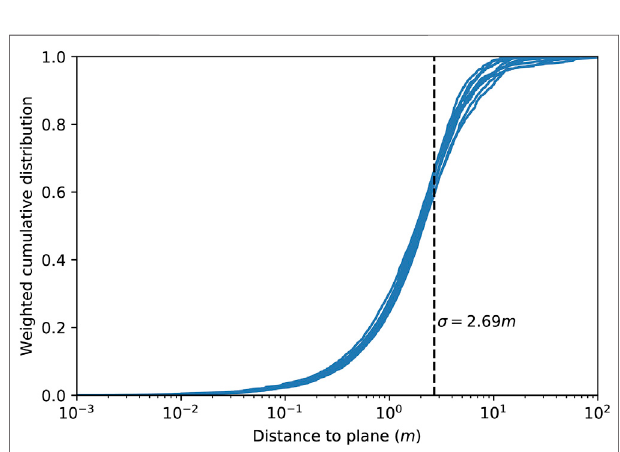
FIGURE 4 | Cumulative distribution of the distance to plane of the DFN realizations ’ segments, weighted by length. The vertical black line shows the sigma distance.